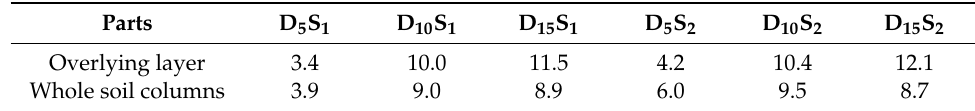
Table 4. The reduction of soil water storage in the overlying layer and the whole sand-layered soil columns (unit: